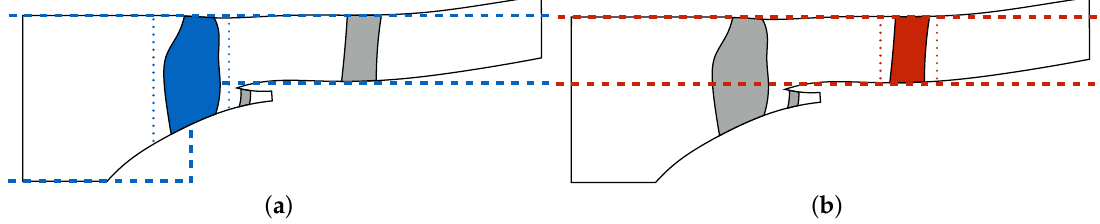
Figure 7. Definition of the annular duct with uniform flow for the application of Goldstein’s analogy for the fan and OGV sources: the horizontal dashed lines define the duct radii, and the vertical dotted lines define the planes on which the variables are averaged. ( a ) Fan sources; ( b ) OGV